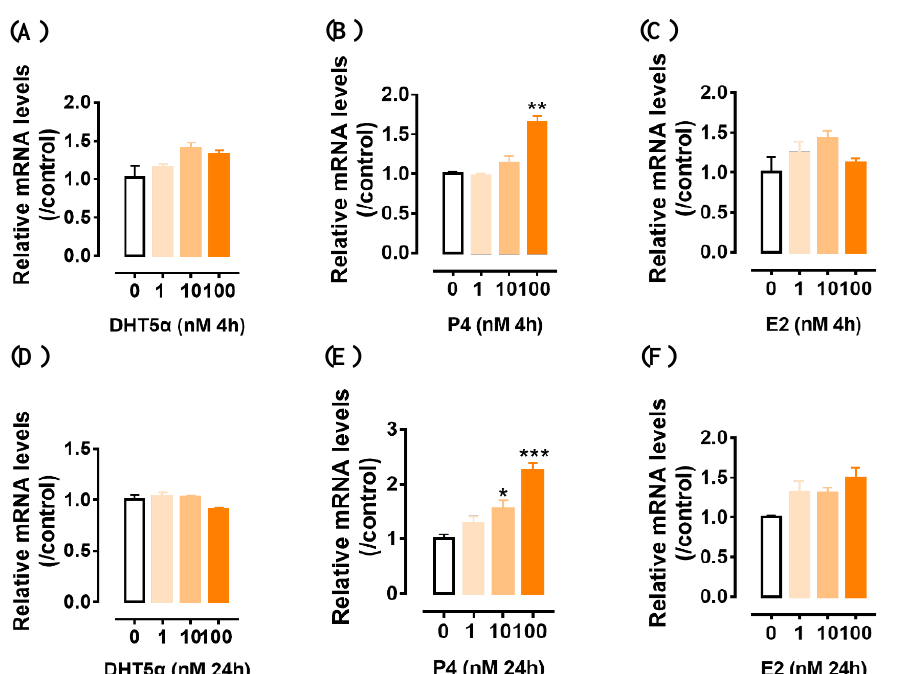
Figure 7. The effects of androgen ( DHT5α ) ( A , D ), progesterone (P4) ( B , E ), and estradiol (E2) ( C , F ) treatment (0 nM, 1 nM, 10 nM, and 100 nM) for 4 h and 24 h on c GPR12 mRNA expression in cultured granulosa cells from 6 – 8 mm follicles as detected by qPCR . Each data point represents the mean ± SEM of 4 replicates ( N = 4). * p < 0.05; ** p < 0.01; *** p < 0.001 vs. control.